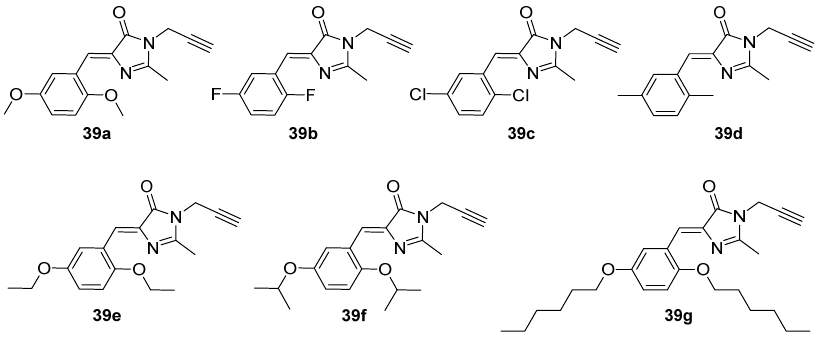
Figure 35. GFPc analogues with their isomerization hampered by benzylidene substituents [26].